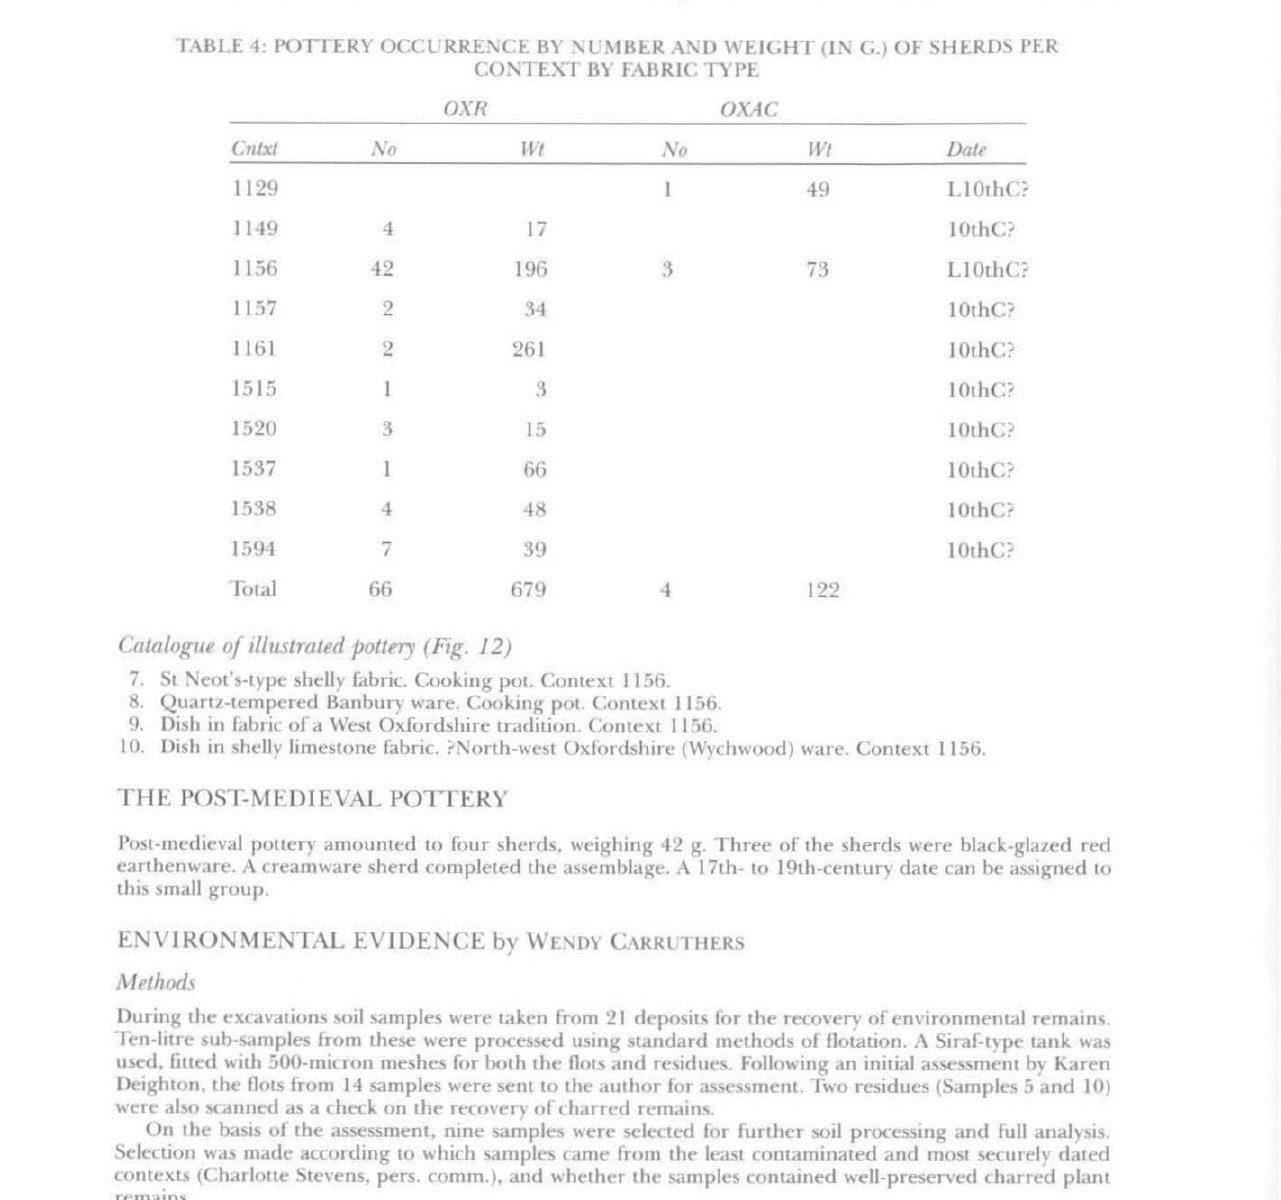
TABLE 4: POTTERY OCCURRENCE BY NUMBER AND WEIGHT (IN G.) OF SHERDS PER CONTEXT BY FABRIC TYPE OXR OXAC CnuJ